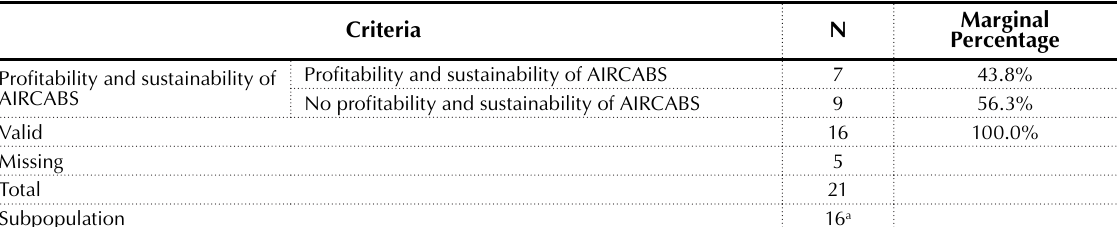
Table 32. Case processing summary